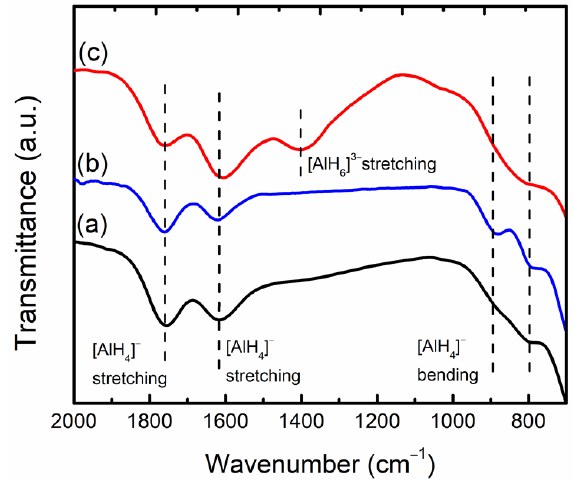
Figure 9. The FTIR profile of ( a ) commercial LiAlH 4 , ( b ) as-milled LiAlH 4 and ( c ) LiAlH 4 + 10 wt.% CoTiO 3 .